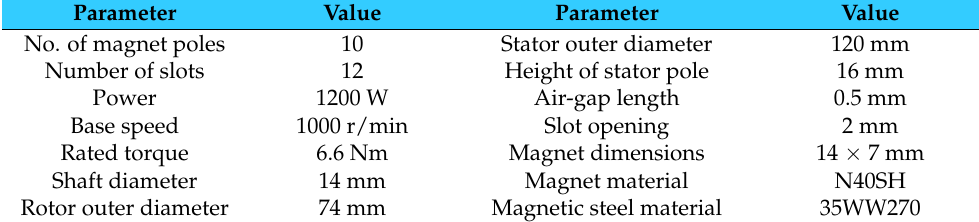
Table 1. The major parameters and dimensions of